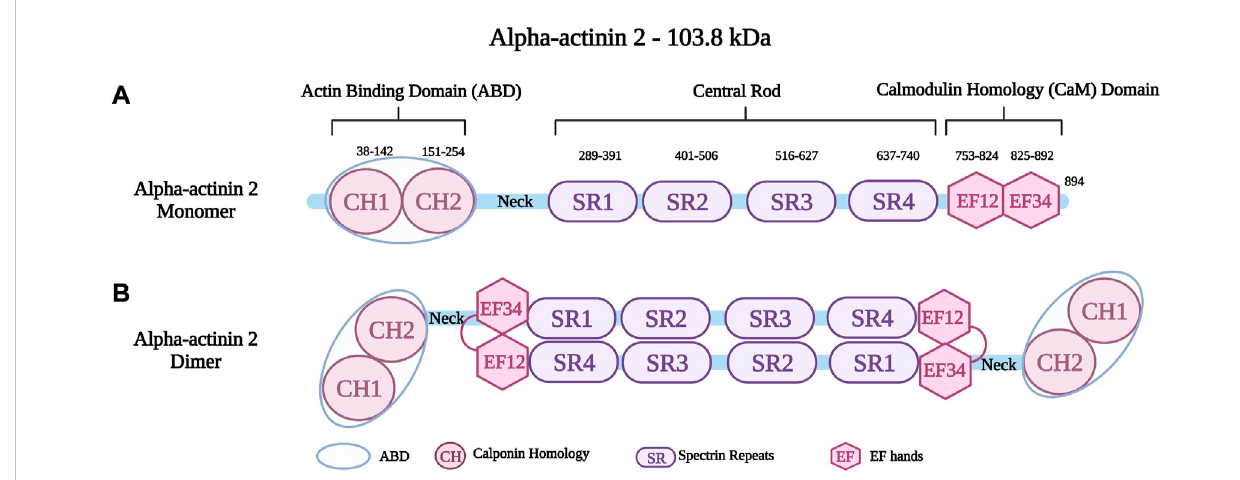
FIGURE 2 (A) Schematicrepresentation of alpha-actinin two monomer with different residues in theActin Binding Domain (ABD), Spectrin repeats(SR) and EF hands (EF). (B) Schematic representation of alpha-actinin two dimer showing the interaction between the neck region and the EF hands. Created with BioRender.com. Adapted from (Haywood et al.,